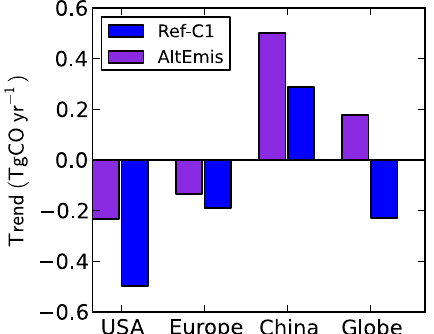
Figure 1. Trends in the CO emissions used in the Ref-C1 and Ref-C1-SD simulations (blue bars) and AltEmis simulation (pur- ple bars) over 2000–2010 for the United States, Europe, China, and the